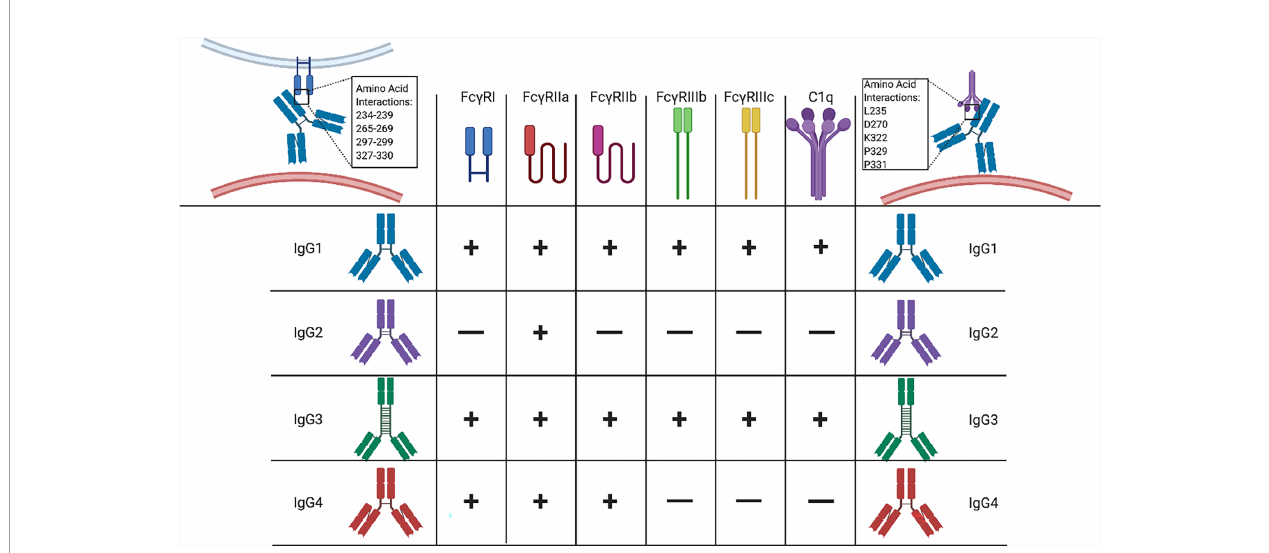
FIGURE 3 | Pre-Existing Autoantibody Characteristics Impact Effector Functions. Autoantibodies bind to a variety of different antigens expressed on the cell surface of damaged cells or damaged/modi fi ed proteins that exist in the extracellular space. Upon binding, autoantibodies work to fi ne-tune the activation or suppression of the immune response. Inherent antibody characteristics such as antigen speci fi city, Ig class, IgG/A subclass, and glycosylation give autoantibodies the ability to regulate the immunological response to stimuli. Antigenic speci fi city is determined by the Fab ’ portion of the antibody while effector function is dependent on the Fc portion of the antibody. Immune responses can be pro-in fl ammatory or anti-in fl ammatory based on the target antigen. Ig classes (IgM/G/A/E/D) have different immune activation capabilities and activate different immune pathways. For example, IgG and IgM are able to fi x complement while IgA, IgD, and IgE are not. IgG/A subclasses are also capable of modulating effector functions. IgG1-4 have different complement fi xation capabilities and interact with different FcyR ’ s, thereby, fi ne- tuning the immune